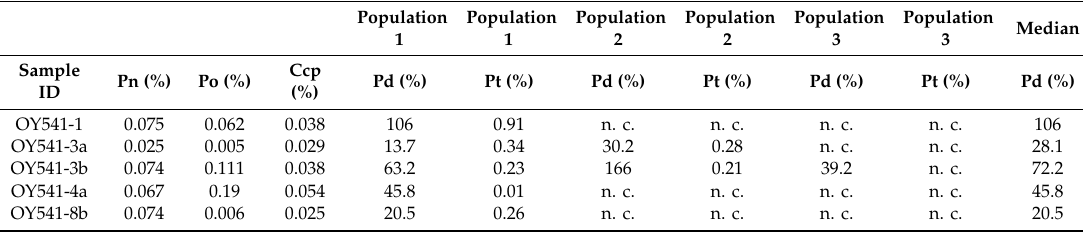
Table 8. Calculated proportions of pentlandite, pyrrhotite, chalcopyrite and Pt, and Pd proportions (in %) hosted by pentlandite in Overysel clinopyroxenite samples.